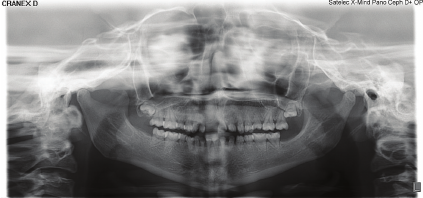
Figure 9: OPG of the patient revealing short clinical crown with conical roots.